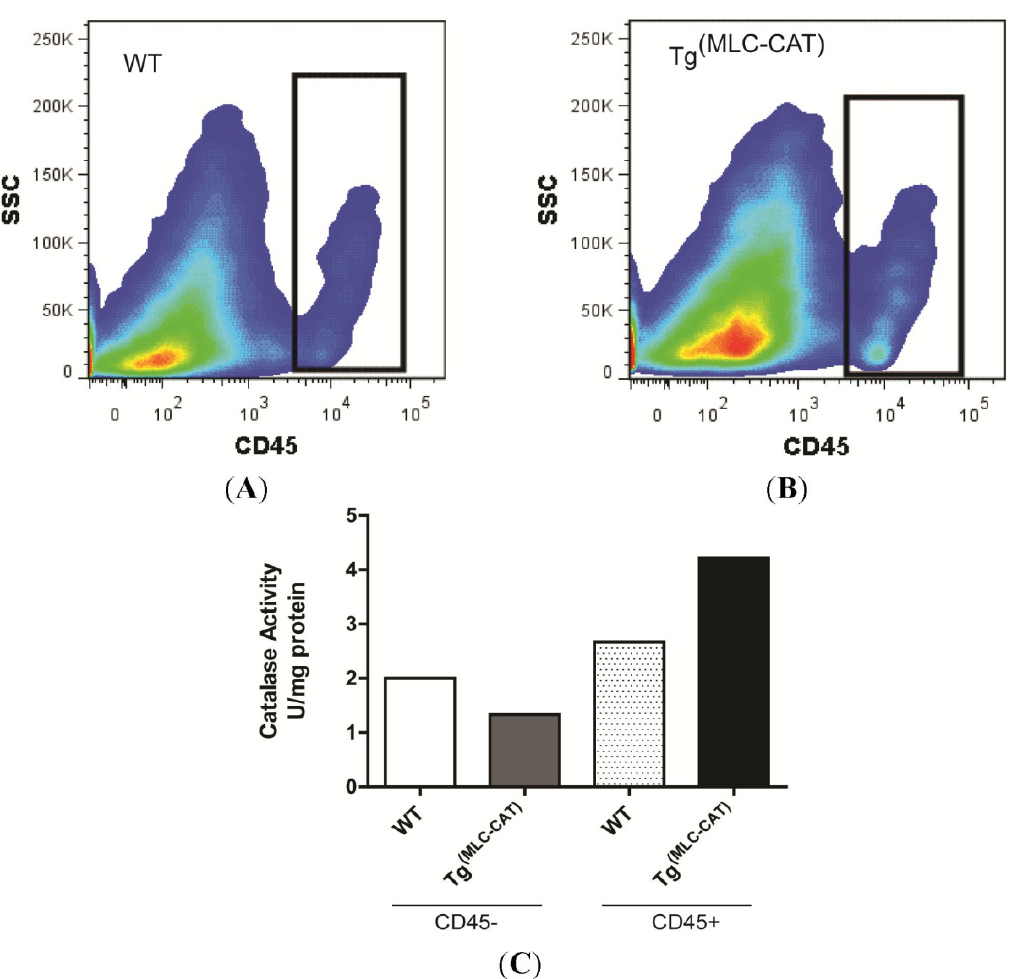
Figure 3. Catalase activity increased in CD45 + cells in Tg (MLC − CAT) mice. Cells were isolated from the left-ventricle 7 days following infarction and collected for analysis of catalase activity. ( A , B ) Representative cell sorting images showing the fraction of CD45 + cells that were collected did not differ between groups (rectangle area denotes CD45 + gate); ( C ) Catalase activity in isolated cells demonstrated a trend for increased activity only in CD45 + cells of Tg (MLC − CAT) mice while CD45 − cells showed no increase. Data are expressed as U/mg protein from pooled samples ( n = 3 per